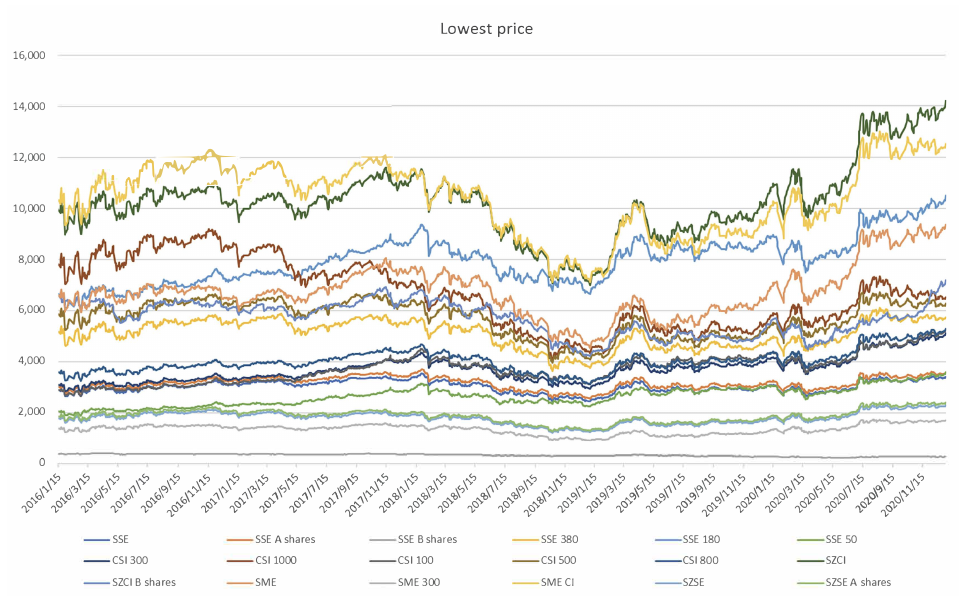
Figure A4. History of lowest price in 18 Chinese stock index.